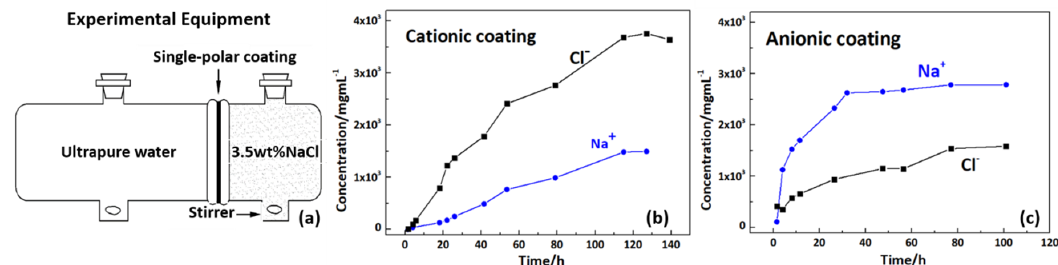
Figure 5. The ion-selectivity of the single-polar coatings. ( a ) Illustration of the custom-designed experimental equipment. ( b ) and ( c ) are the plots of the concentrations of Na + and Cl − in ultrapure water versus increasing time for the cationic and anionic coatings.